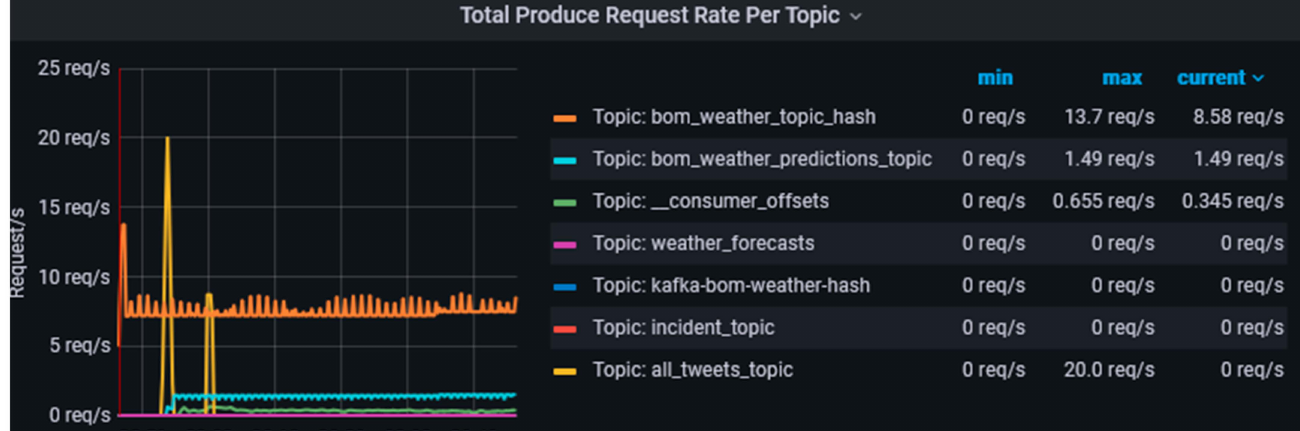
Figure 6. Producer Request Rate indicating ability of the platform to handle